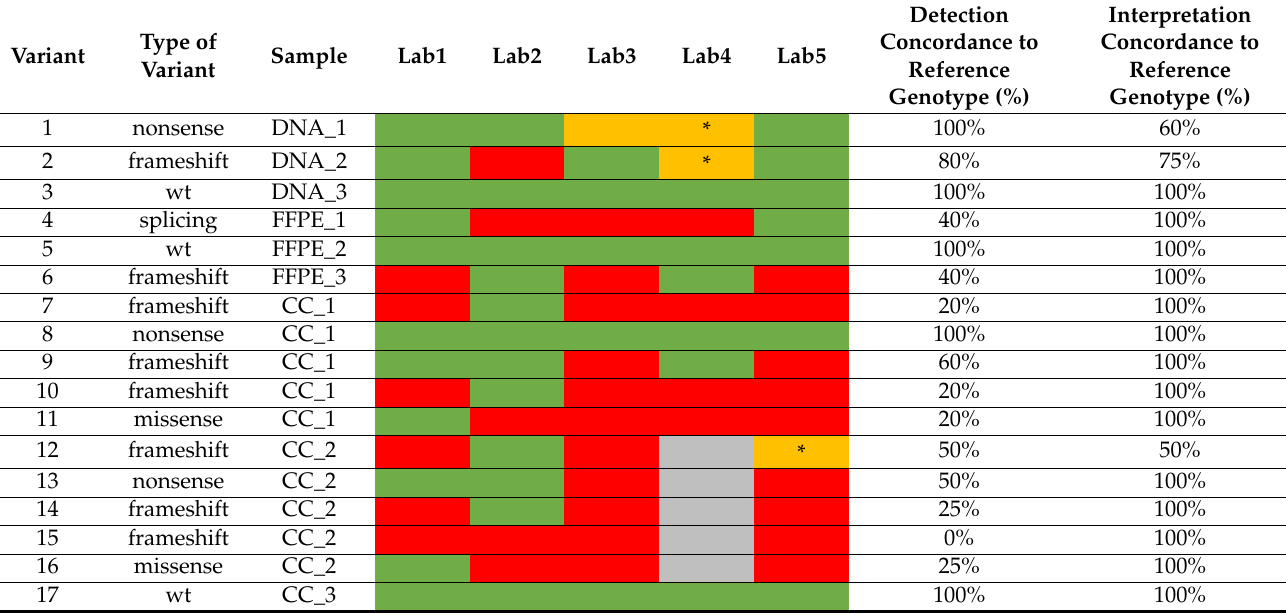
Table 6. Summary of BRCA1/2 variants and results obtained in the